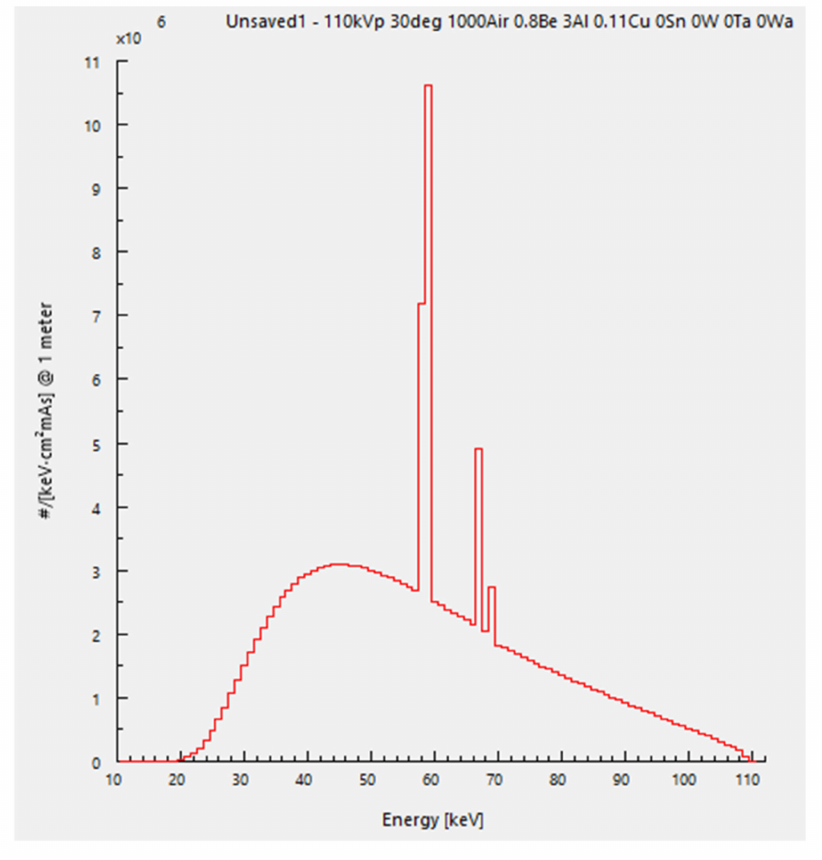
Figure 4. Energy spectrum of the incident